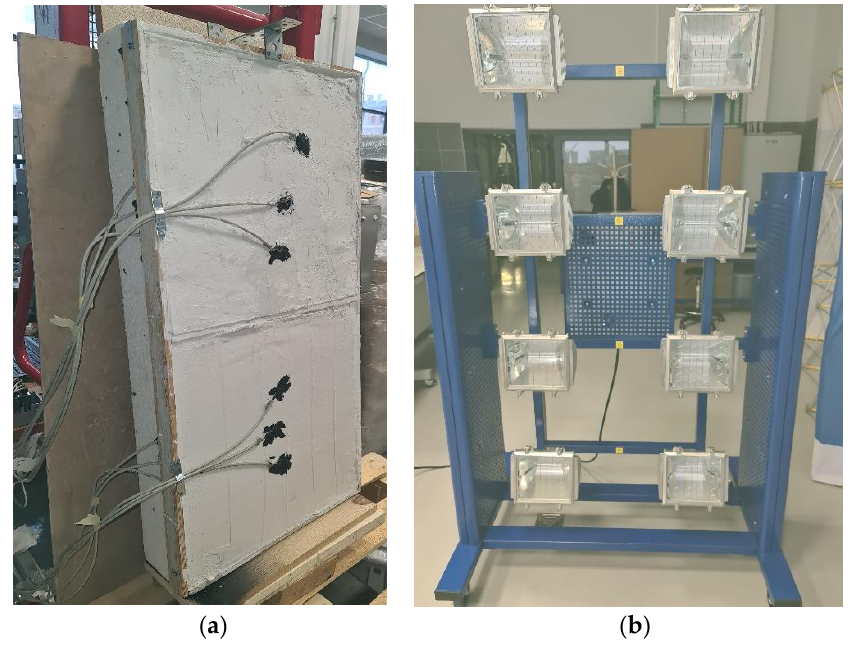
Figure 3. ( a ) Gypsum boards attached to the measuring station; ( b ) SYLVANIA lamps generating 1000 W of